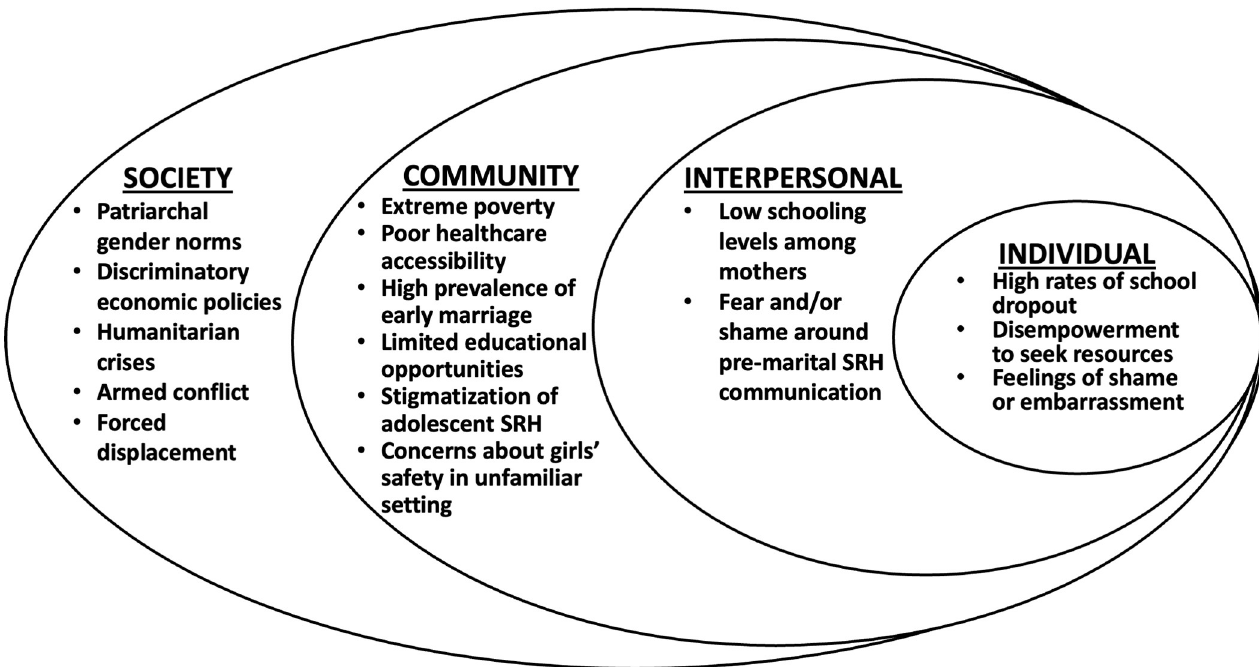
Fig 1. Social ecological framework for barriers to accessing SRH information among adolescent Syrian refugee girls.